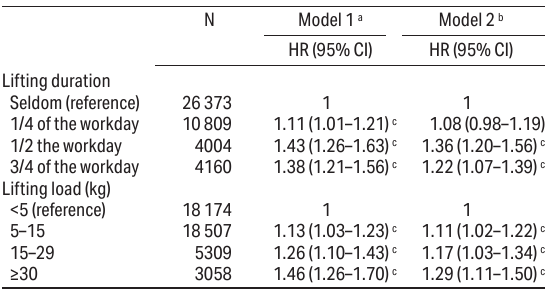
Table 2. Association between lifting duration or lifting load and risk of long-term sickness absence among all workers. [HR=hazard ratio; CI=confidence